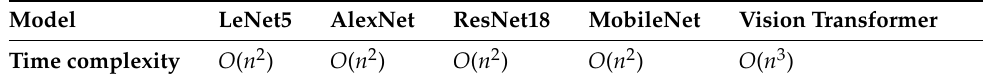
Table 2. The time complexity of each